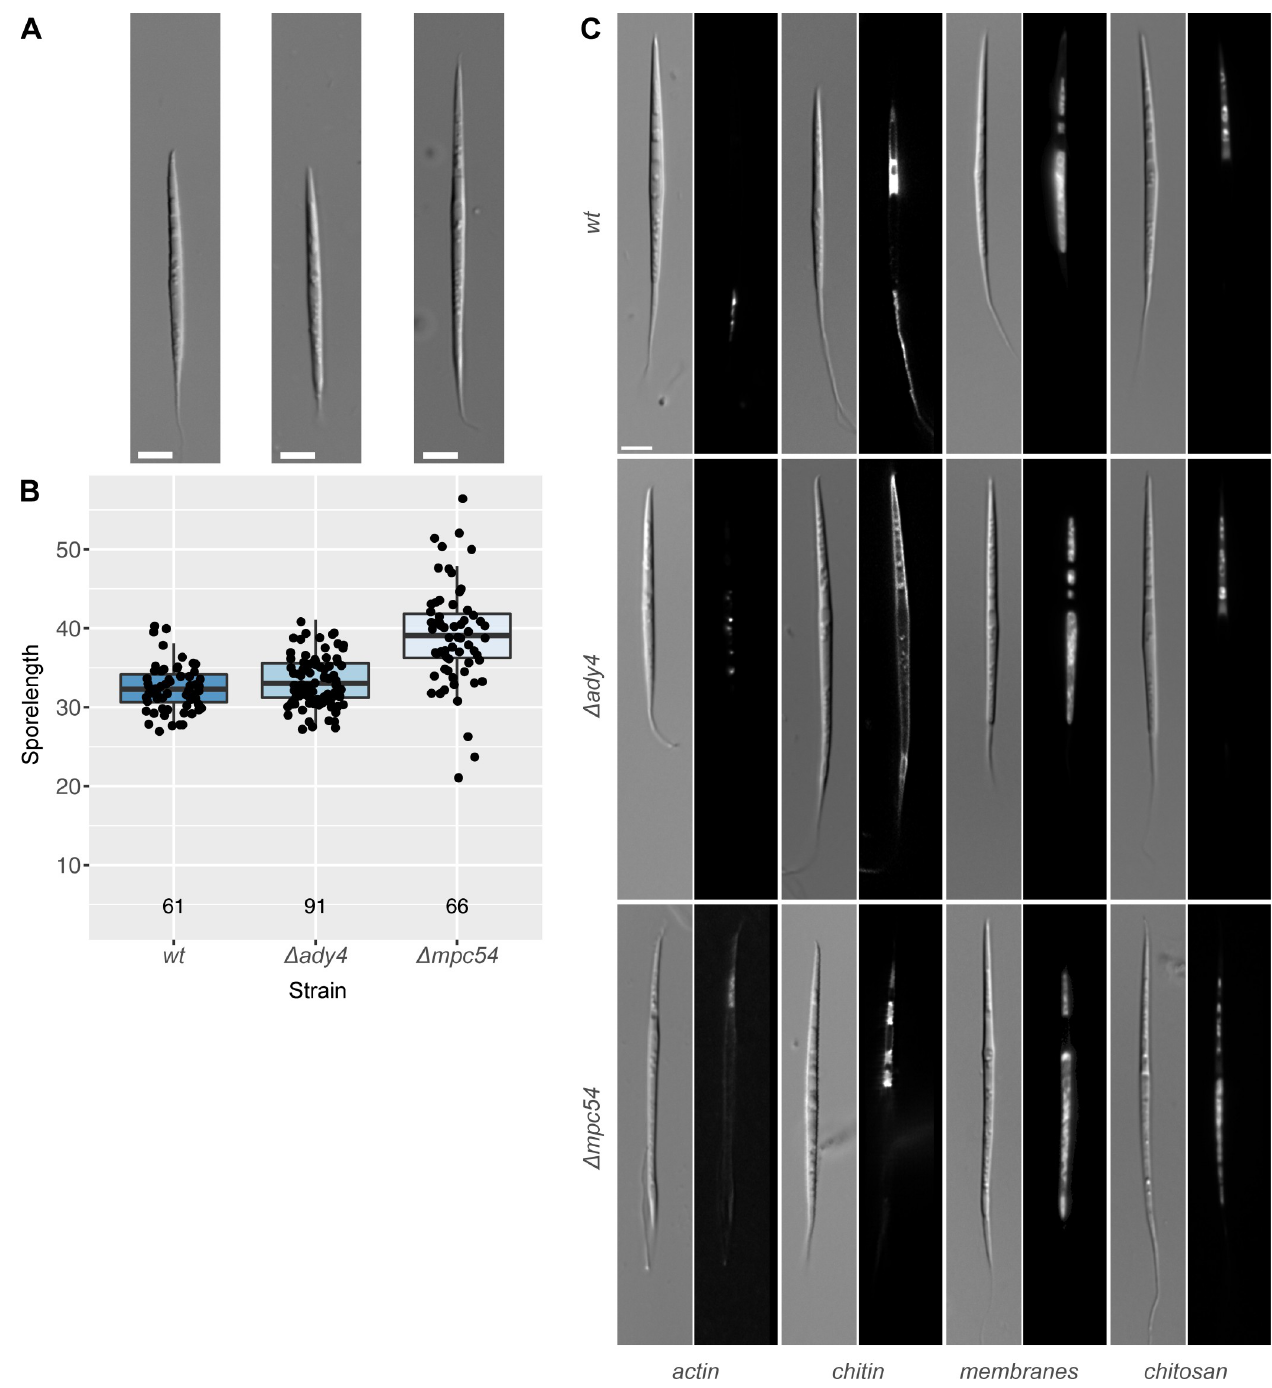
Fig 6. Phenotypes of spores from ady4 and mpc54 deletion mutants. A) Representative images of spores. The scale bar represents 5 μ m. B) Boxplot of spores length measured for the indicated strain. The horizontal bar in the box represents the median. The hinges represent the 25th and 75th percentiles. The whiskers extend 1.5 times the inter-quartile range from each hinge. Individual data is plotted as an overlaid scatter plot. The number plotted below each bar represents the number of spores measured for each strain. C) Actin staining was performed using rhodamine-phalloidin; chitin was stained with calcofluor white; membranes were stained using DiOC6(3), chitosan was visualized using eosin Y.